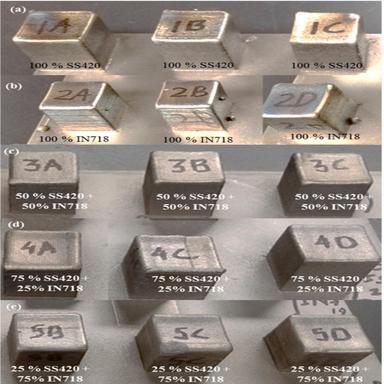
Five different SS420-IN718 multi-material mixtures in weight percentage processed using laser-DED technique. a) 100% SS420, b) 100% IN718 c) 50% SS420–50% IN718, d) 75% SS420–25% IN718, e) 25% SS420–75% IN718.